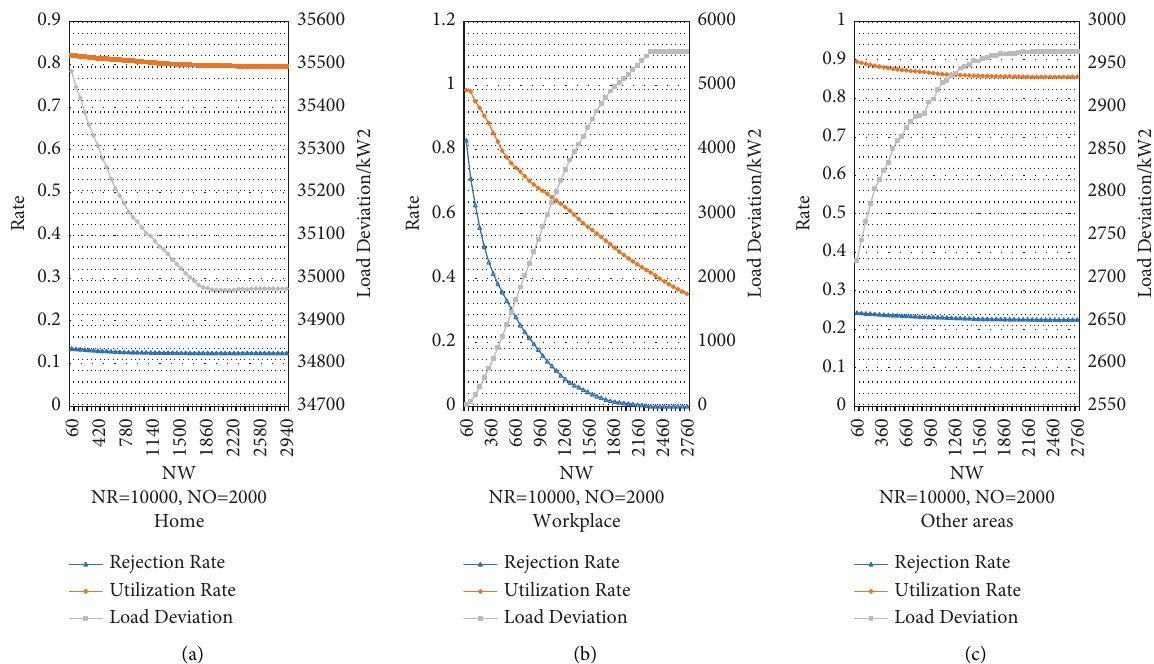
Figure 6: Influence of the number of charging piles in workplace areas (NW) on operational efficiency. (a) Home. (b) Workplace. (c) Other areas.